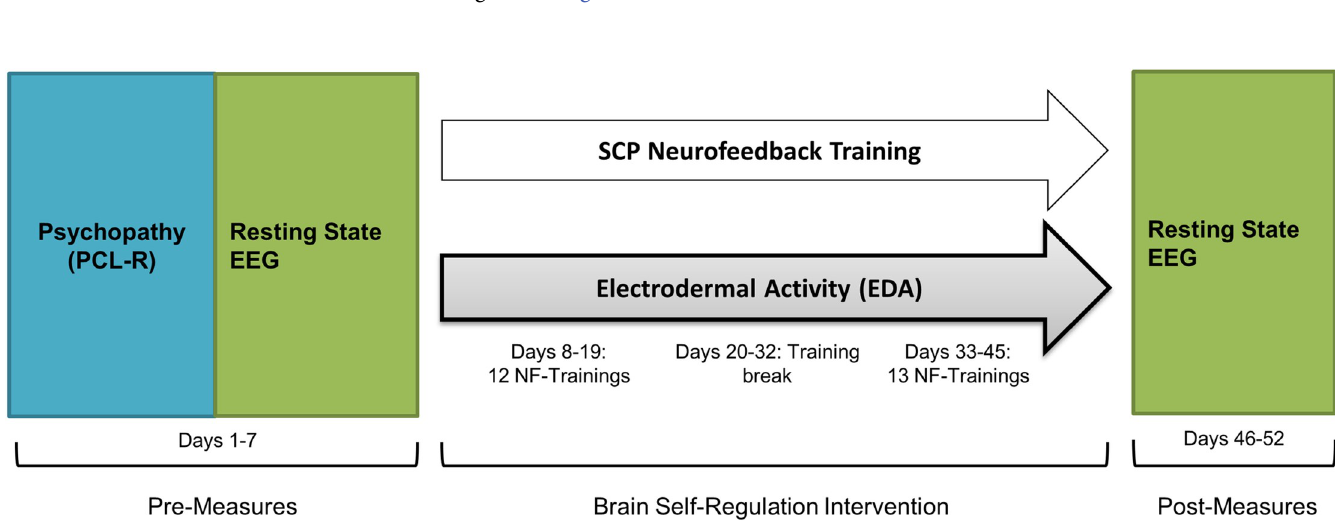
Fig 2. Study overview. Initial clinical assessment: psychopathy (blue); Pre-/Post-measures: resting state EEG (green); Intervention: SCP-neurofeedback training; Measures during intervention: (a) Cortical measure: SCP activation (white), (b) Peripheral-physiological measures: Electrodermal activity (grey). SCP training consisted of 25 training sessions, each split into three training blocks with different conditions (feedback–transfer–feedback) and tasks (negativity–positivity) of 8 minutes per block.